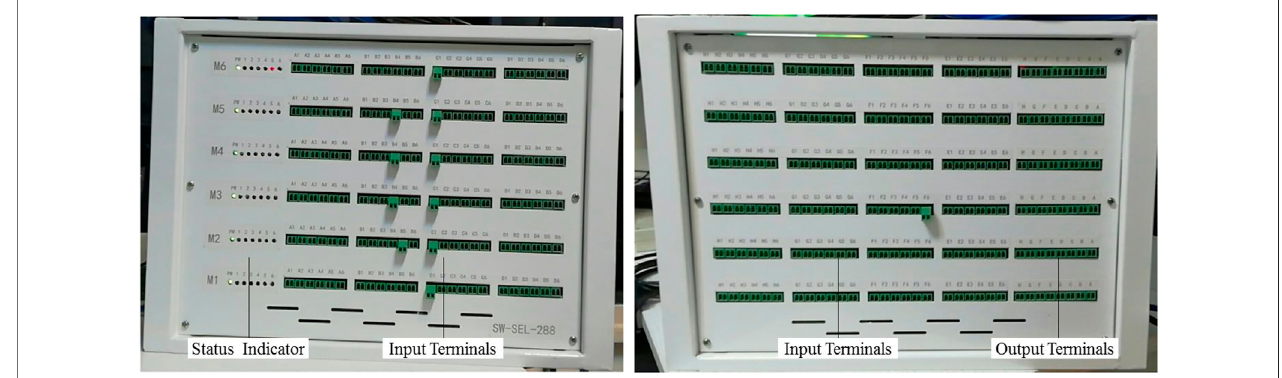
FIGURE 5 | Picture of multi-channel selector.